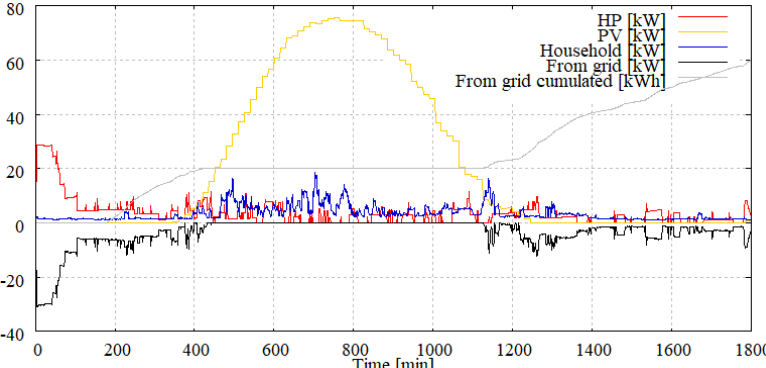
Figure 8. Cluster daily electrical demand without optimization.